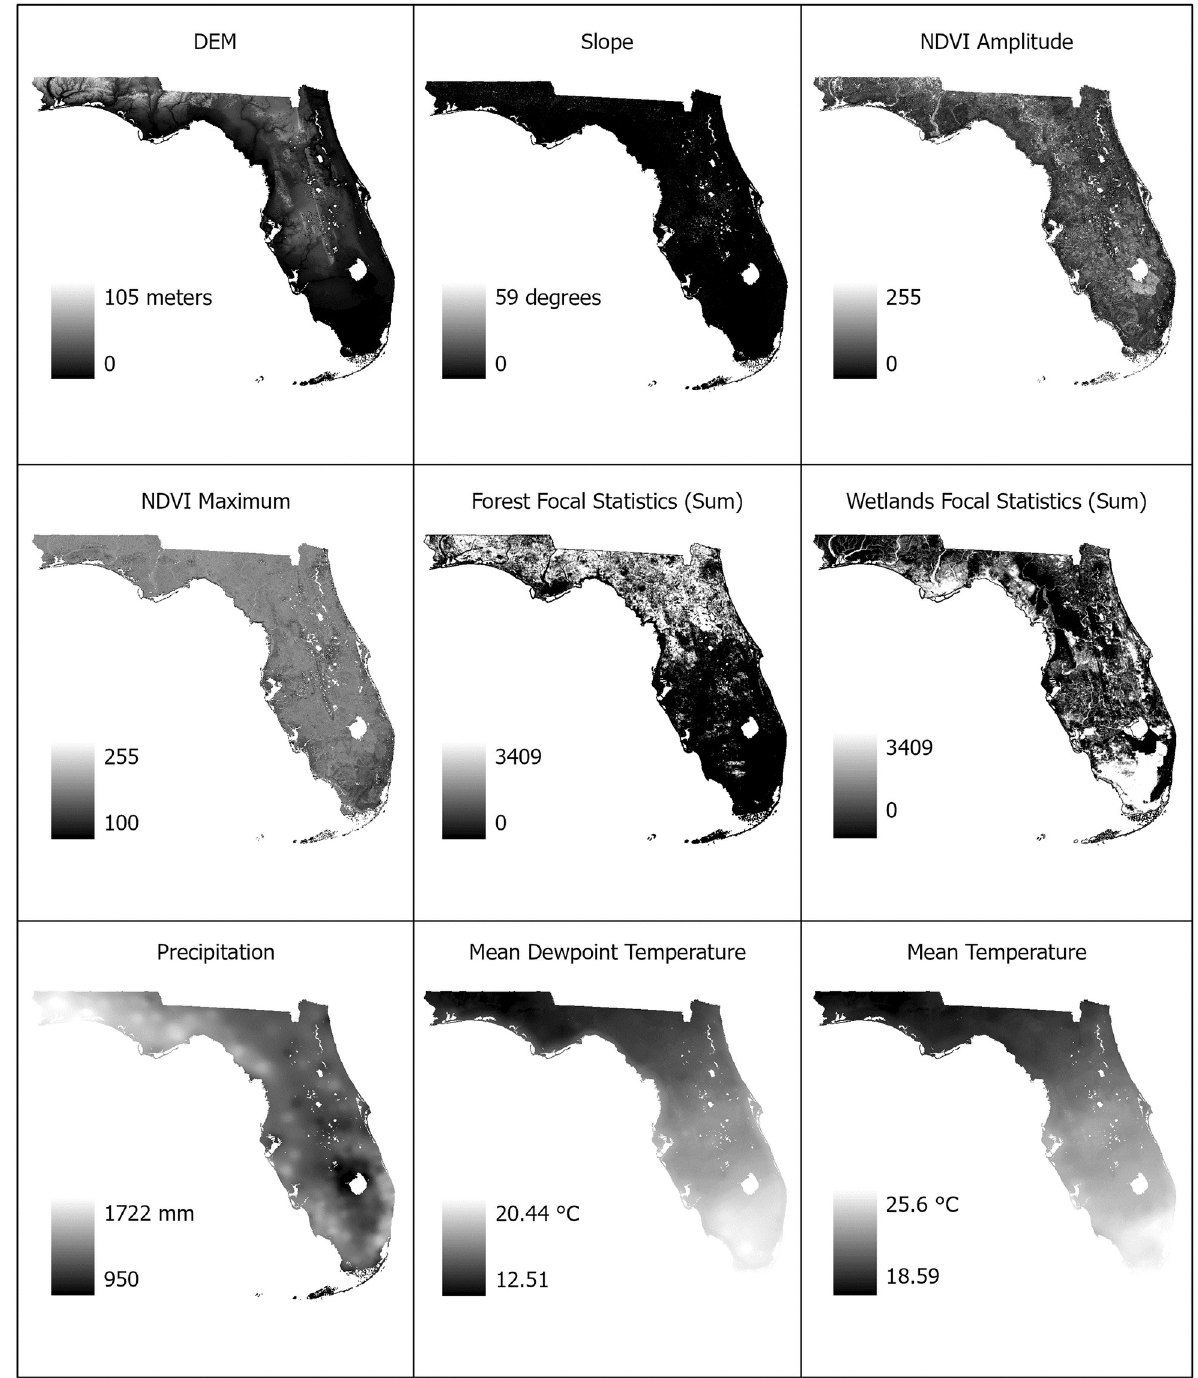
Fig 1. Predictor variable rasters. The above rasters represent the environment spatial variables used for this study. The Digital Elevation Model (DEM) is expressed in meters above sea level. Slope is expressed in degrees from 0 to 90. NDVI amplitude and maximum are unitless and based on NDVI units. Forest and wetland focal statistics indicate the sum of the cells within a 1000-meter circular neighborhood with forest or wetland characteristics, respectively. Precipitation is expressed in millimeters. Mean dewpoint temperature and mean temperature are expressed in degrees